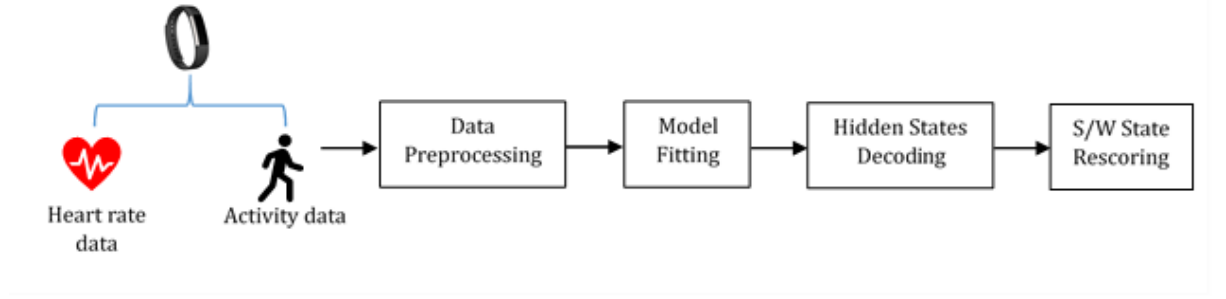
Figure 3. The workflow of our hidden Markov model–based sleep/wake identification approach. S/W: